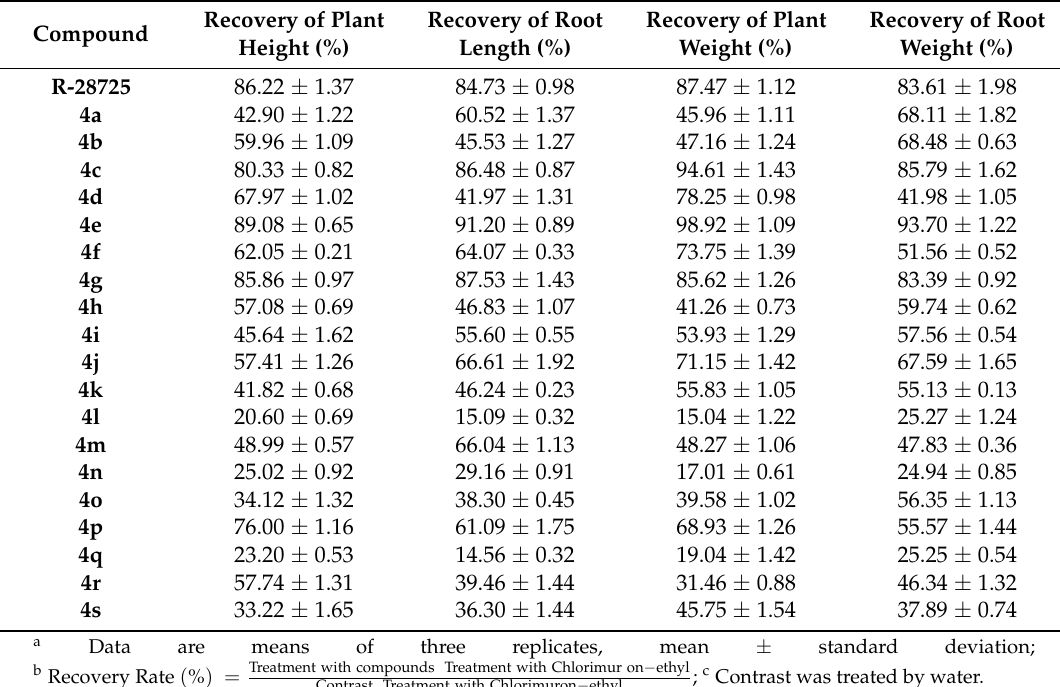
Table 2. Protective effects of Compound 4 to maize a,b,c